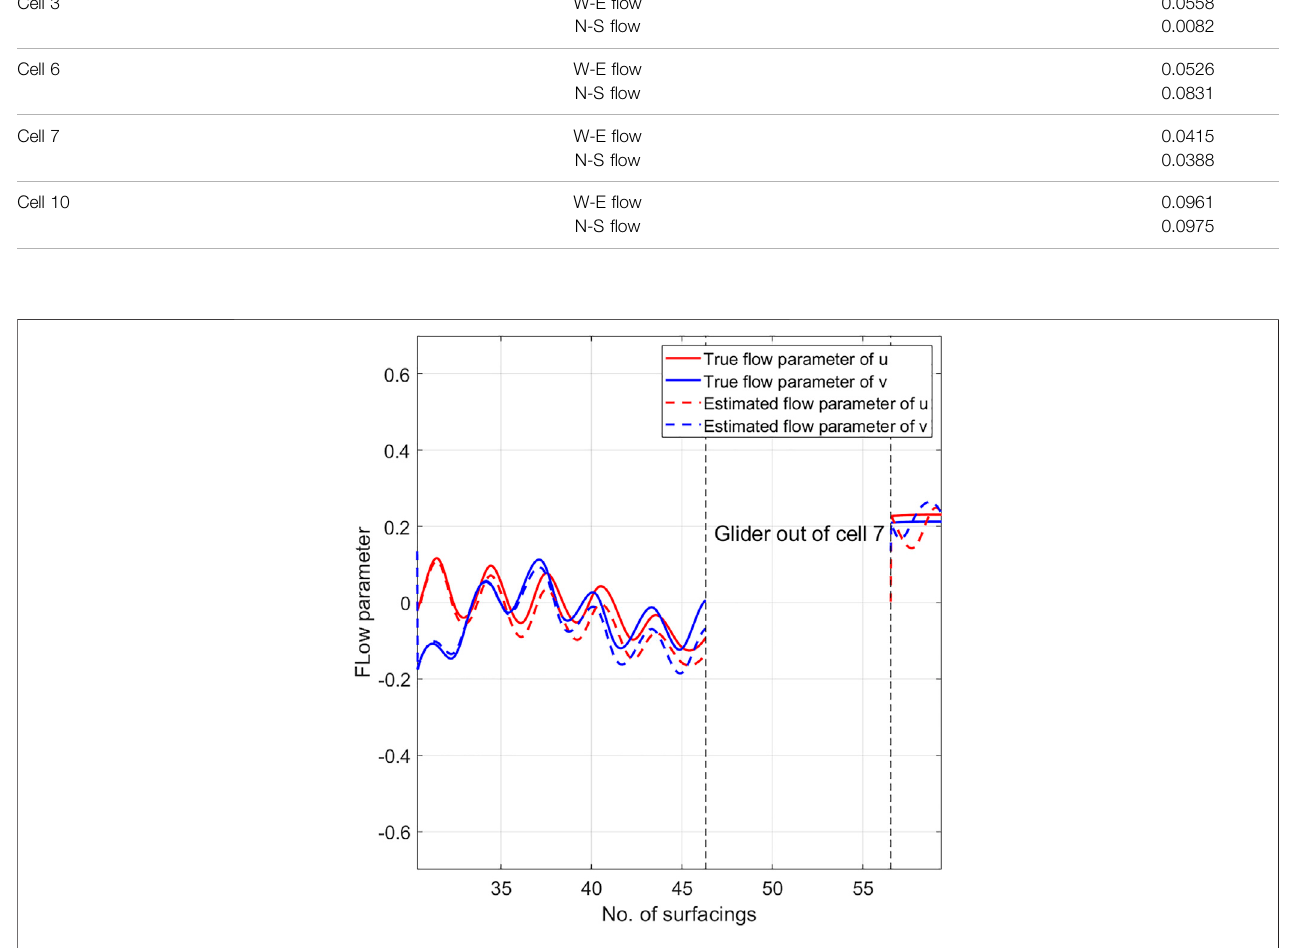
FIGURE 6 | Estimated fl ow parameters and the ground truth value in cell